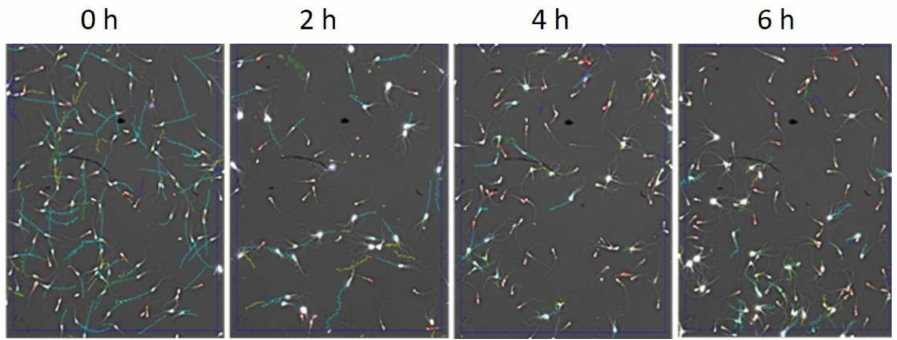
Figure 4. Time-lapse photos showing the degree of agglutination of the bull sperm after 0, 2, 4